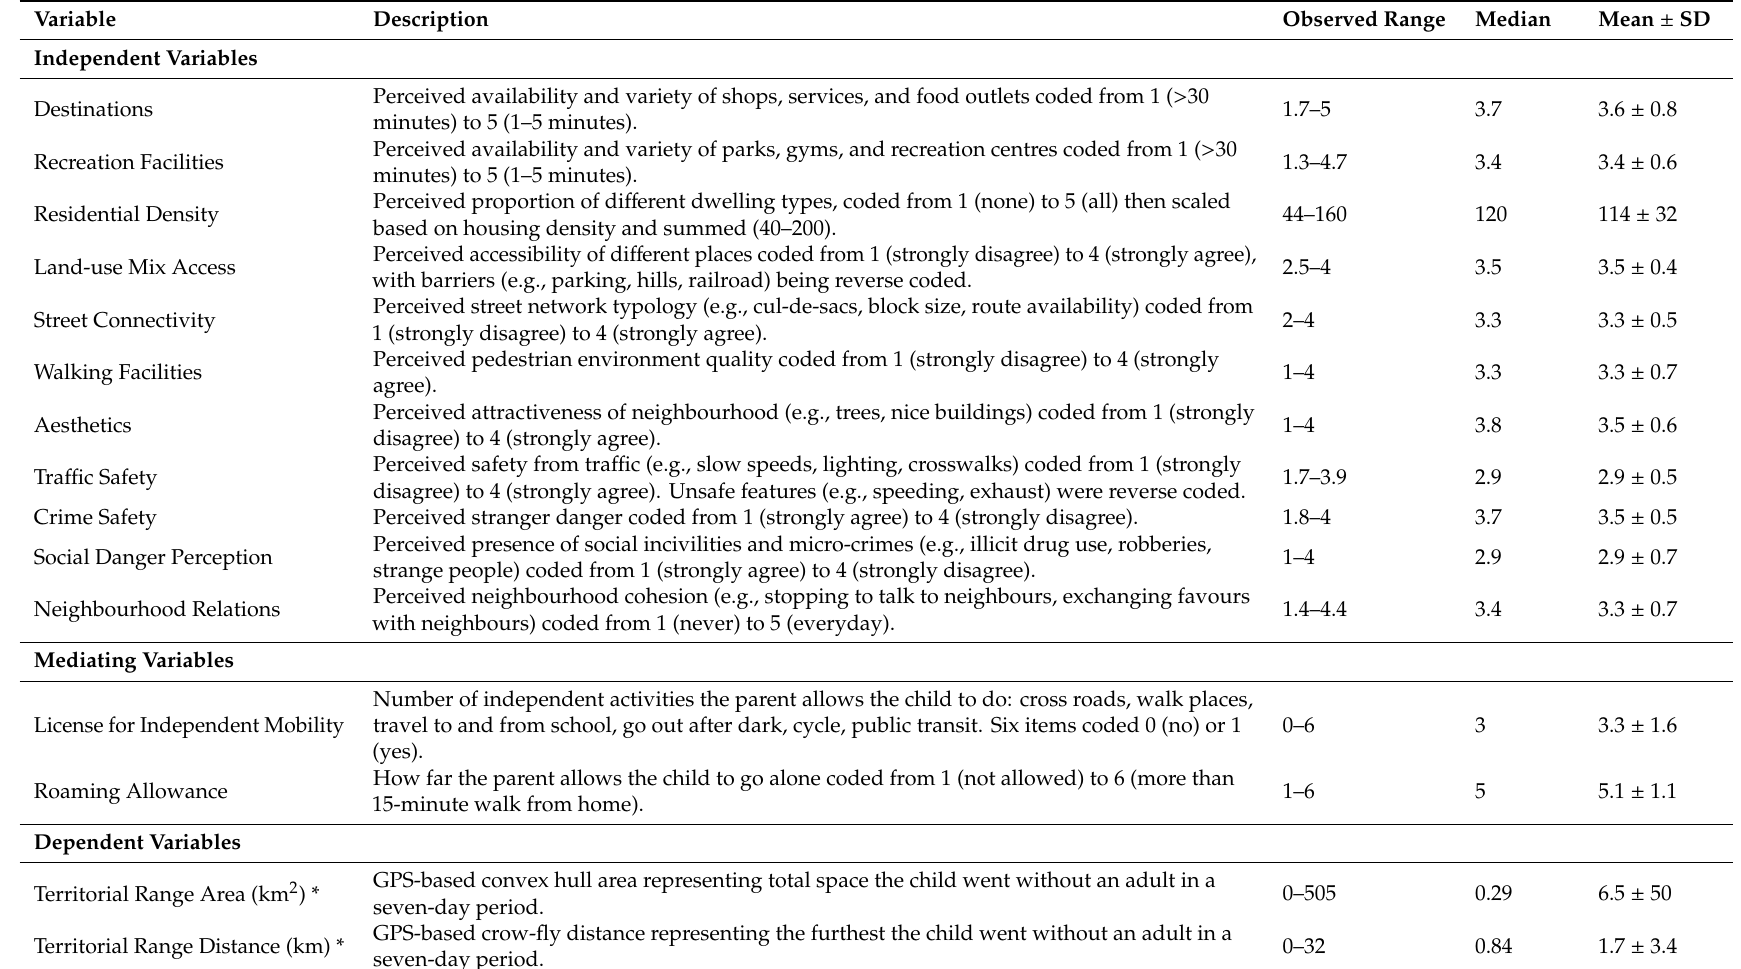
Table 3. Descriptive statistics for parental perceptions of the neighbourhood environment, IM parenting practices, and children’s territorial range (N =